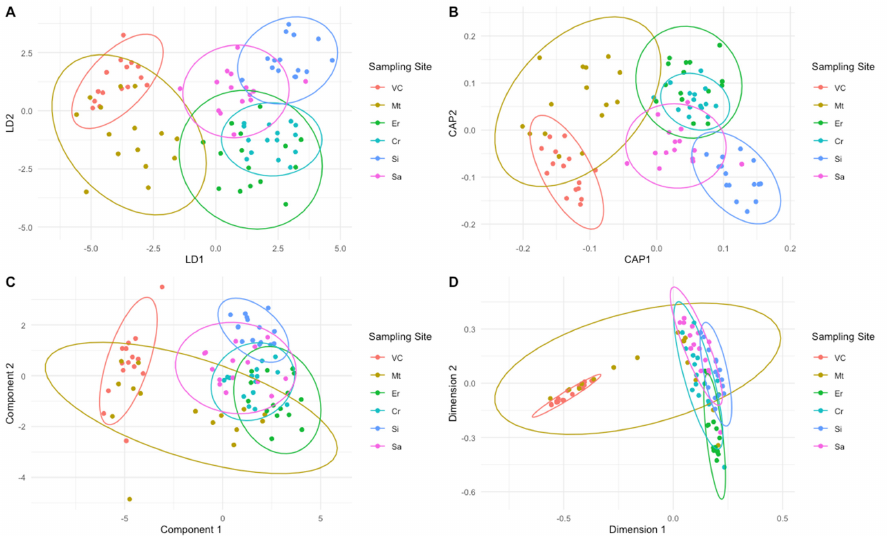
Figure 4. Linear discriminant analysis (LDA, A ), canonical analysis of principal components (CAP, B ), partial least-squares discriminant analysis (PLS-DA, C ) and random forests (RF, D ) projection plots of the Pollicipes pollicipes peduncle elemental profiles, from the individuals collected at Viana do Castelo (VC), Matosinhos (Mt), Ericeira (Er), Cabo Raso (Cr), Sines (Si) and Sagres (Sa) sampling sites. Molecules 2022 , 27 , x FOR PEER REVIEW Table 1. Partial least-squares discriminant analysis (PLS-DA), variable importance in projection par- tial least-squares discriminant analysis (VIP-PLS-DA), linear discriminant analysis (LDA), stepwise